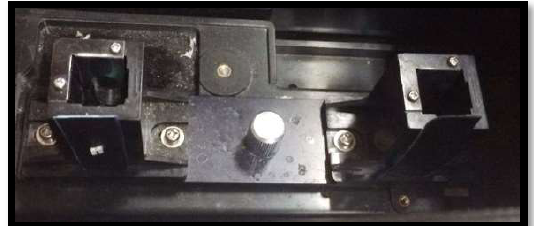
Figure 1: The bracket was positioned on the analytical beam handle of the spectrophotometer and the blank on the other analytical beam handle. Table 1: Descriptive statistics of light absorption and media difference in each duration for the brackets bonded with Enlight, Resilience and Transbond adhesives.